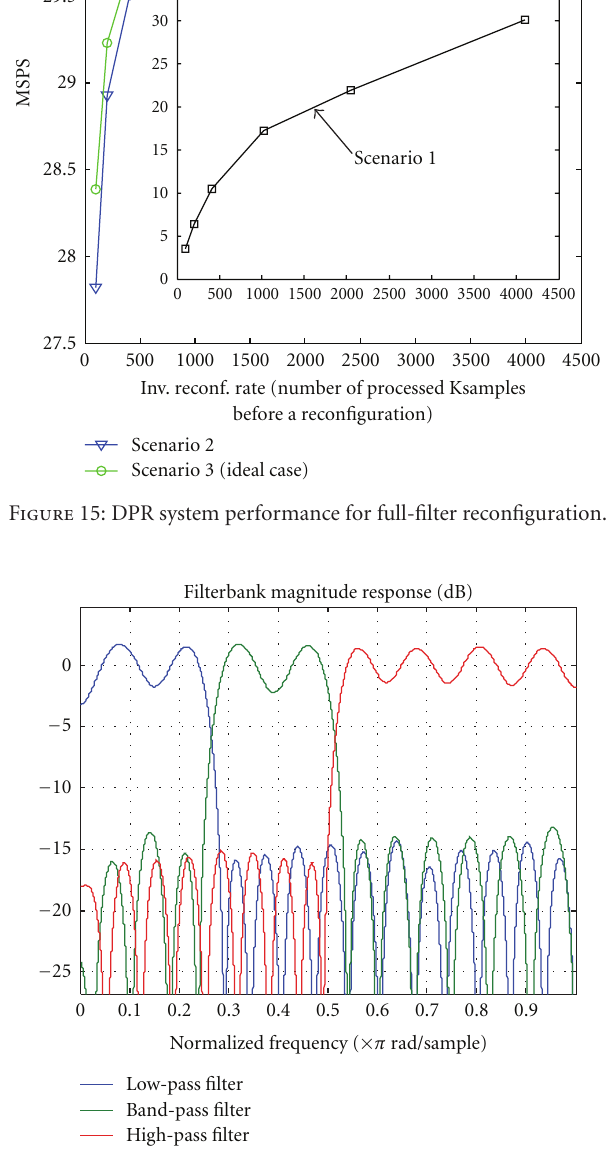
Figure 16: Filterbank used for R-wave